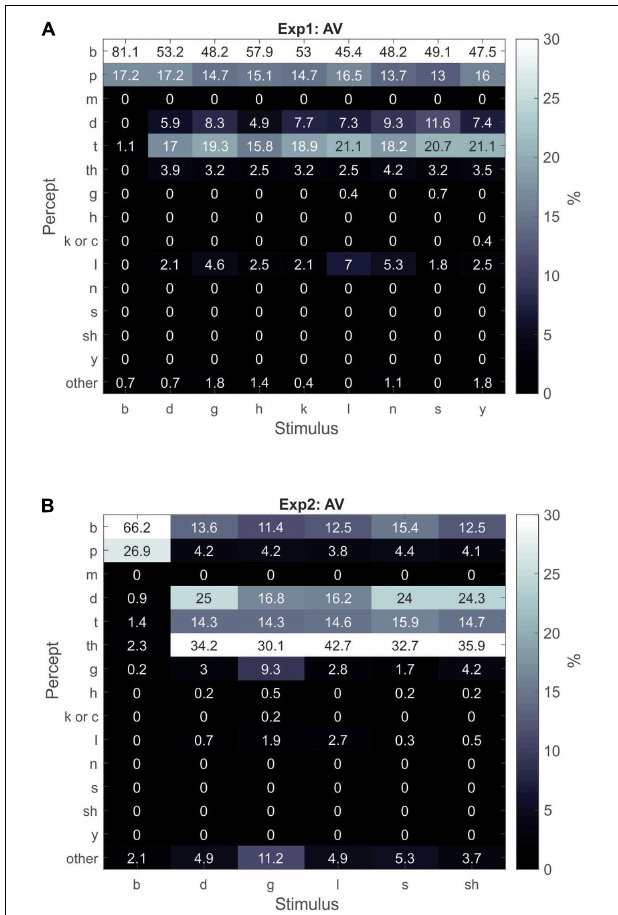
FIGURE 2 | Gray-scale matrix depicting percentages of percepts in response to congruent /ba/ AV utterances and incongruent AV utterances of various visual CVs combined with audio /ba/ for Experiment1 (A) and Experiment2 (B) . The percentage for each percept was calculated as the percentage of responses of the percept relative to all other responses within a stimulus